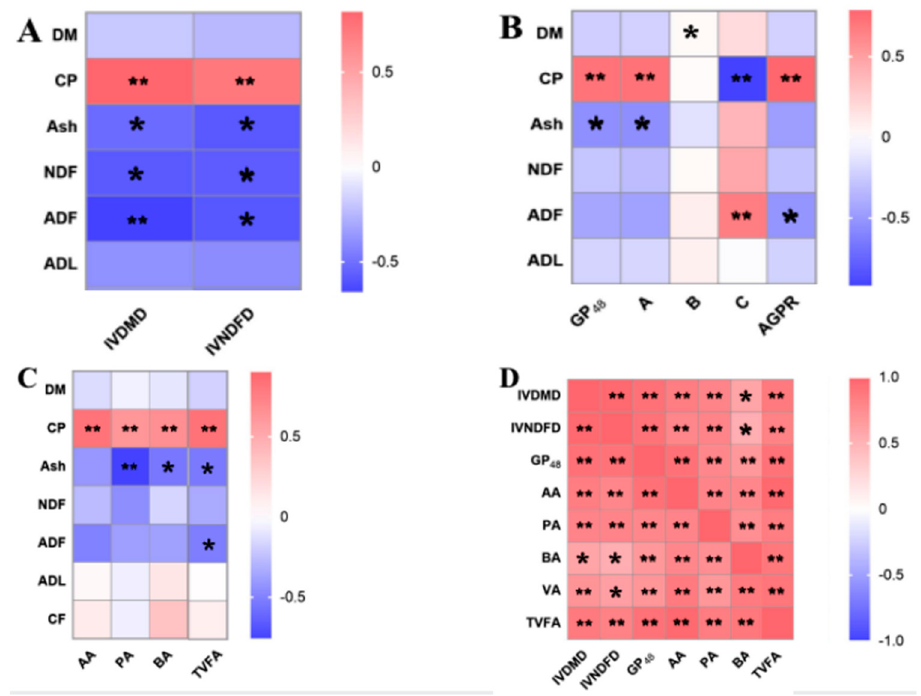
Figure 2. Correlations among the chemical composition, gas production, rumen fermentation parameters and in vitro degradability of rice straw. ( A ) Correlation between the chemical composition and in vitro digestibility of rice straw; ( B ) correlation between the chemical composition and gas production kinetic parameters; ( C ) correlation between the chemical composition and rumen fermentation parameters; ( D ) correlation among the in vitro digestibility, gas production and rumen fermentation parameters of rice straw. AA stands for acetic acid; PA: propionic acid; BA: butyric acid; TVFA: total volatile acid; DM: dry matter; CP: crude protein; NDF: neutral detergent fiber; ADF: acid detergent fiber; ADL: acid detergent lignin; IVDMD: in vitro dry matter degradability; IVNDFD: in vitro neutral detergent fiber degradability; GP: total gas production (mL/g DM) at time t; AGPR: The gas production rate when the maximum gas production is reached 1/2. * showed that the P < 0.05; **, indicates that P < 0.001. Blue represents a negative correlation and red represents a positive correlation.